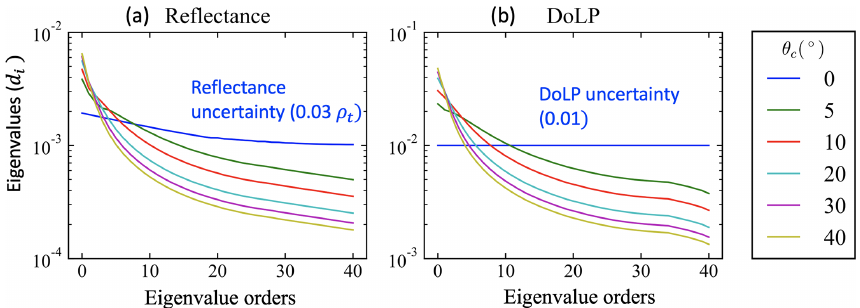
Figure B1. The uncertainties for reflectance and DoLP of the error covariance matrix at the 670nm band after eigenvector decomposition as discussed in Sect. 2.4. These values correspond to the square root of the diagonal values in matrix D (cid:15) from Eq. (7).